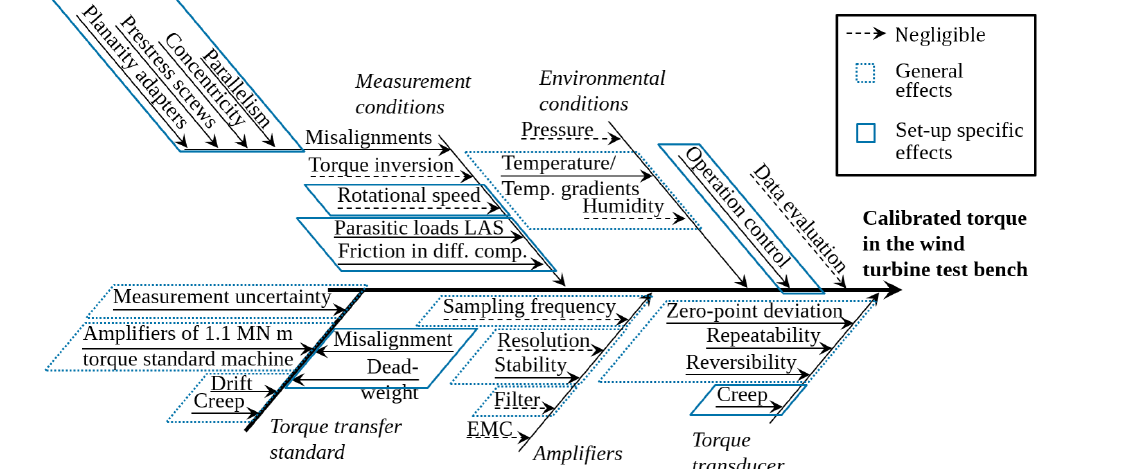
Figure 7. Ishikawa diagram listing the influences on the calibrated torque in the WTTB with the present set-up.